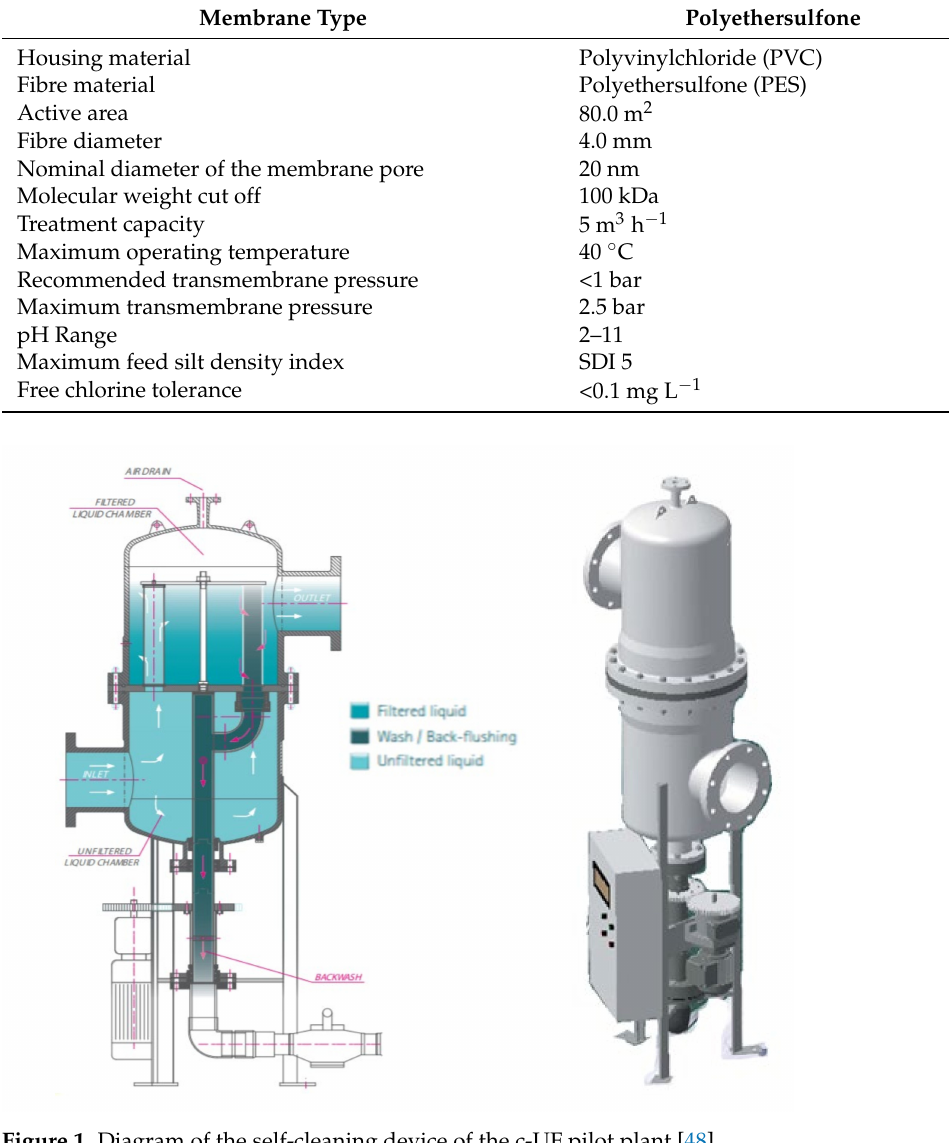
Figure 1. Diagram of the self-cleaning device of the c-UF pilot plant [48]. The reject stream and the wash waters were treated by an ozonation process in a pilot-scale gas-liquid contactor connected to the c-UF equipment. The ozonisation pi- lot system consisted of a 33.03 L stainless steel cylindrical contactor (with dimensions 795 mm × 230 mm), where the wastewater to be treated was introduced. Ozone was pro- duced from extra pure oxygen in the ozone generator (TRIOGEN LAB2B, Triogen, De Goor, The Netherlands) and introduced into the reactor through a gas diffuser installed at the bottom of contactor, thus ensuring a perfect homogenization of the system. To improve the contact between the descending liquid and ascending gas, the column is provided on the top by a spray that atomizes the liquid. Part of the dissolution that the centrifugal pump (TMP04.08 S GF VN2BEN3, Argal Pumps, Brescia, Italy) recirculates is thrown up and returns to the reactor at the top where it is sprayed, which can also destroy the